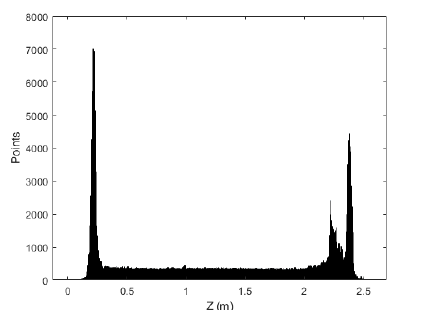
Figure 5. The histogram of z coordinates showing distinct peaks corresponding to floor and two-height ceilings.